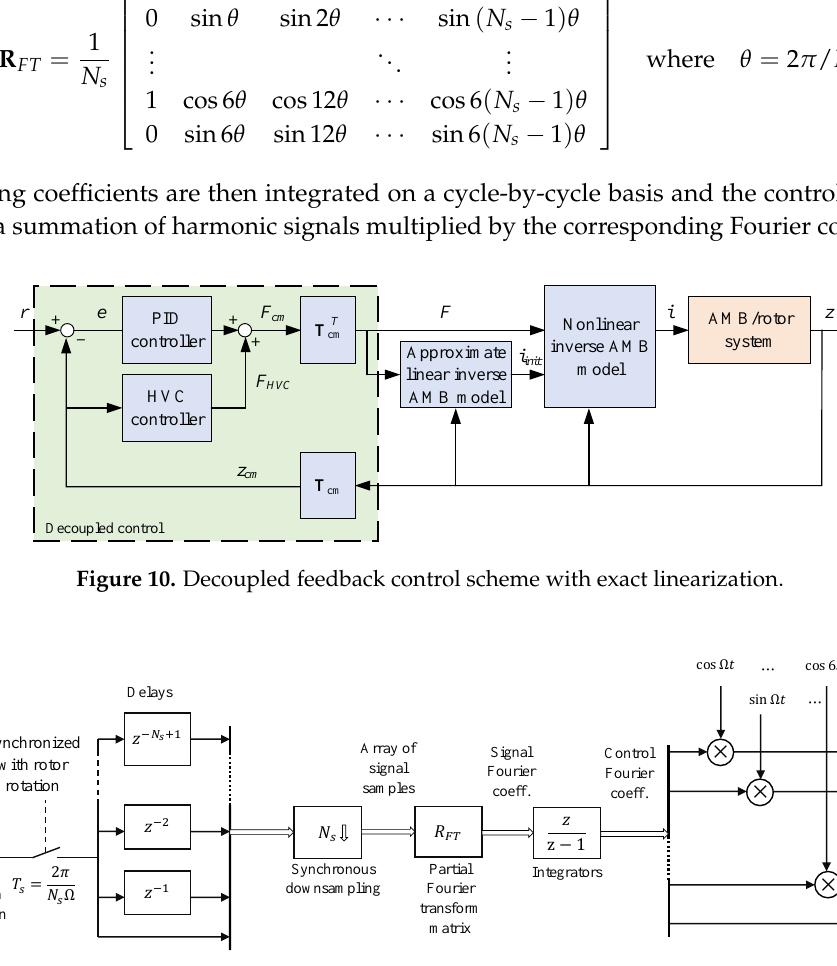
Figure 11. Harmonic vibration control